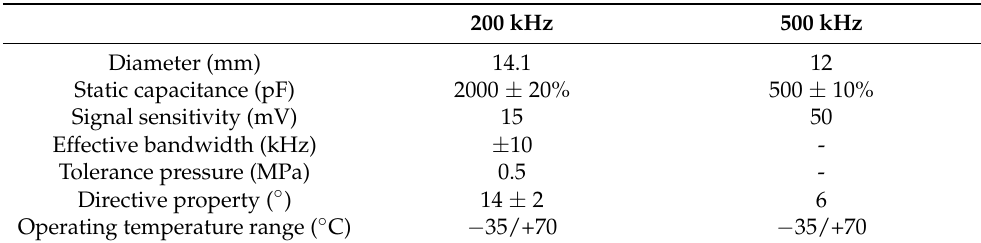
Table 2. Features of the selected transducers.